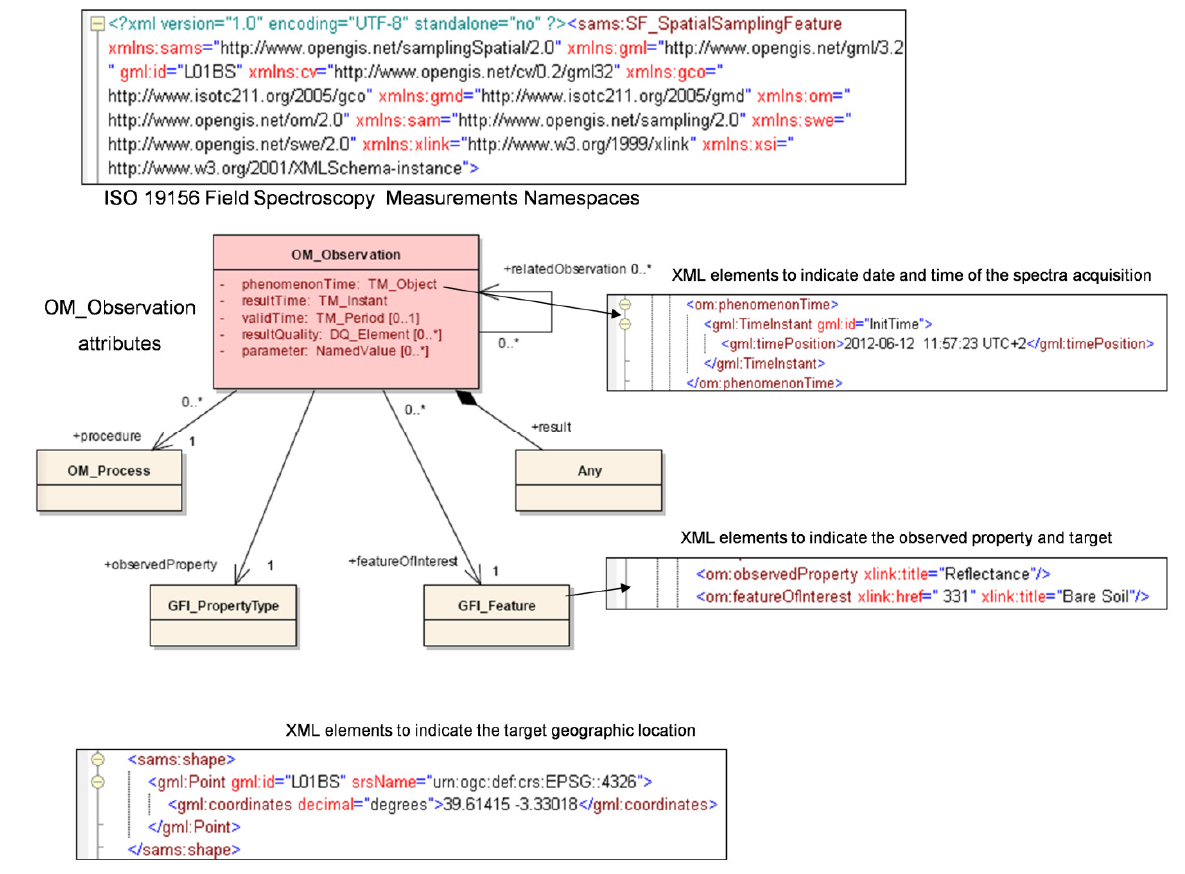
Figure 5. ISO 19156 (ISO-O&M) profile for the reflectance spectral library.